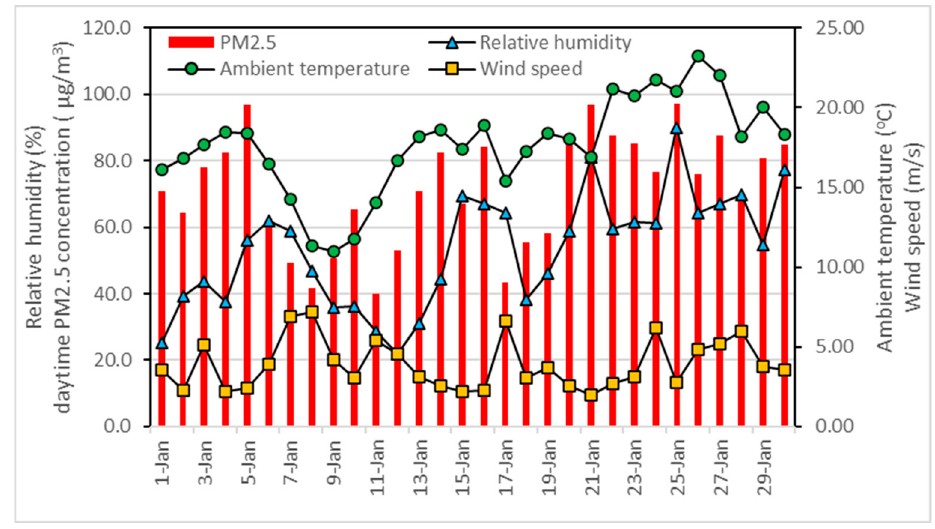
Figure 2. The daytime average concentration of PM 2.5 and meteorological conditions during the sampling period in January 2021.